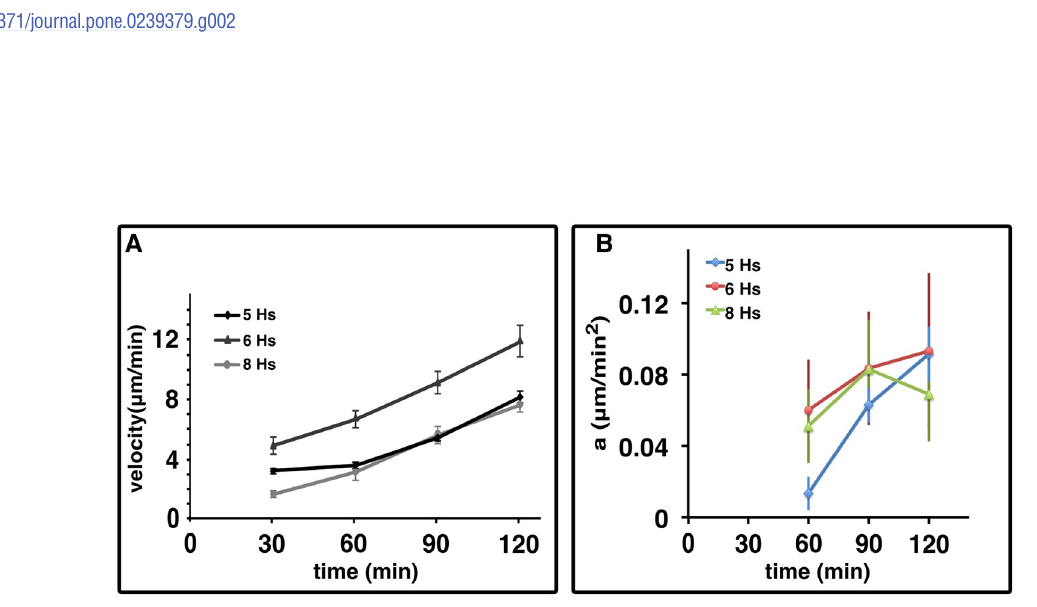
PLOS ONE | https://doi.org/10.1371/journal.pone.0239379 September 18,